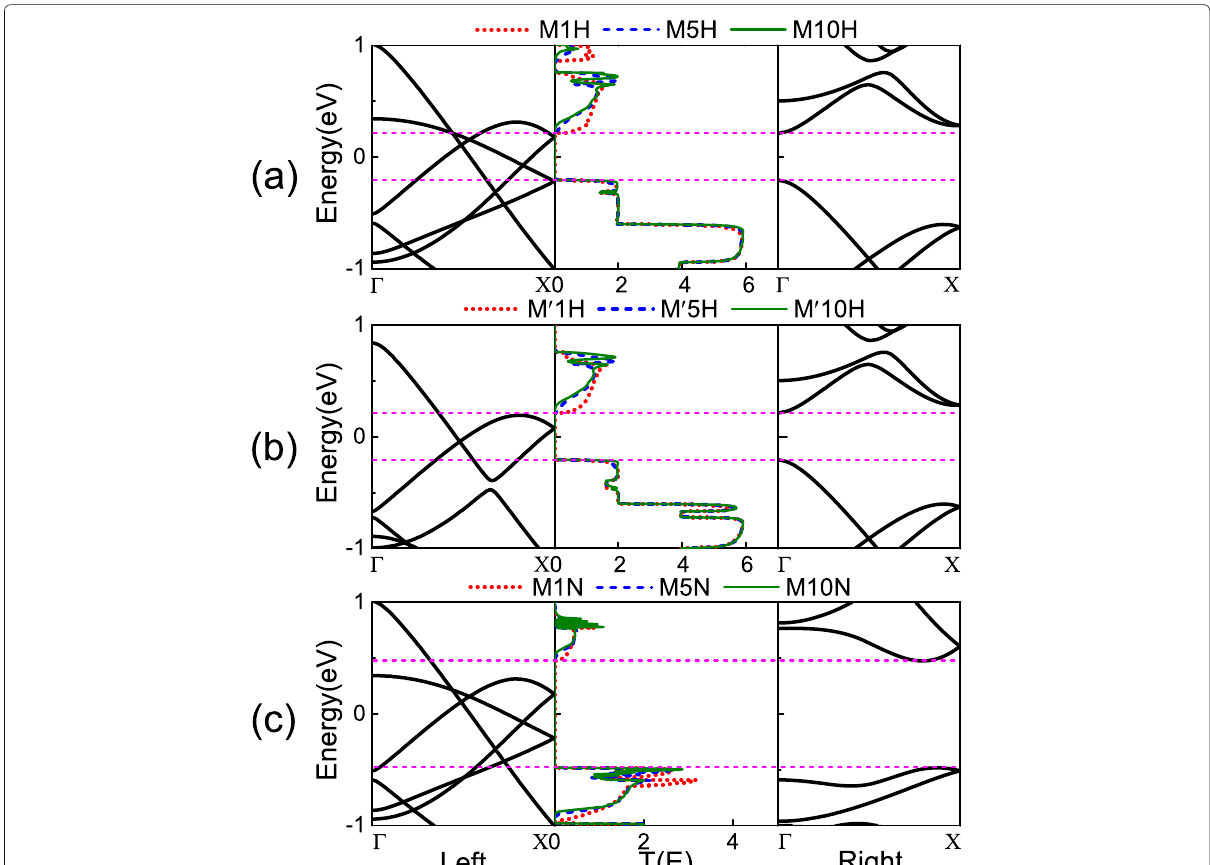
Fig. 4 The band structure of the left and right electrode, where the Fermi level is set to zero and the magenta dashed lines indicate the band gap of the right semiconductor electrode. The transmission spectra at zero bias for heterojunctions a M n H, b M (cid:2) n H, and c M n N with n =1 (red dashed line), 5 (blue dashed line), and 10 (green solid line) are correspondingly shown in the middle part of each figures,